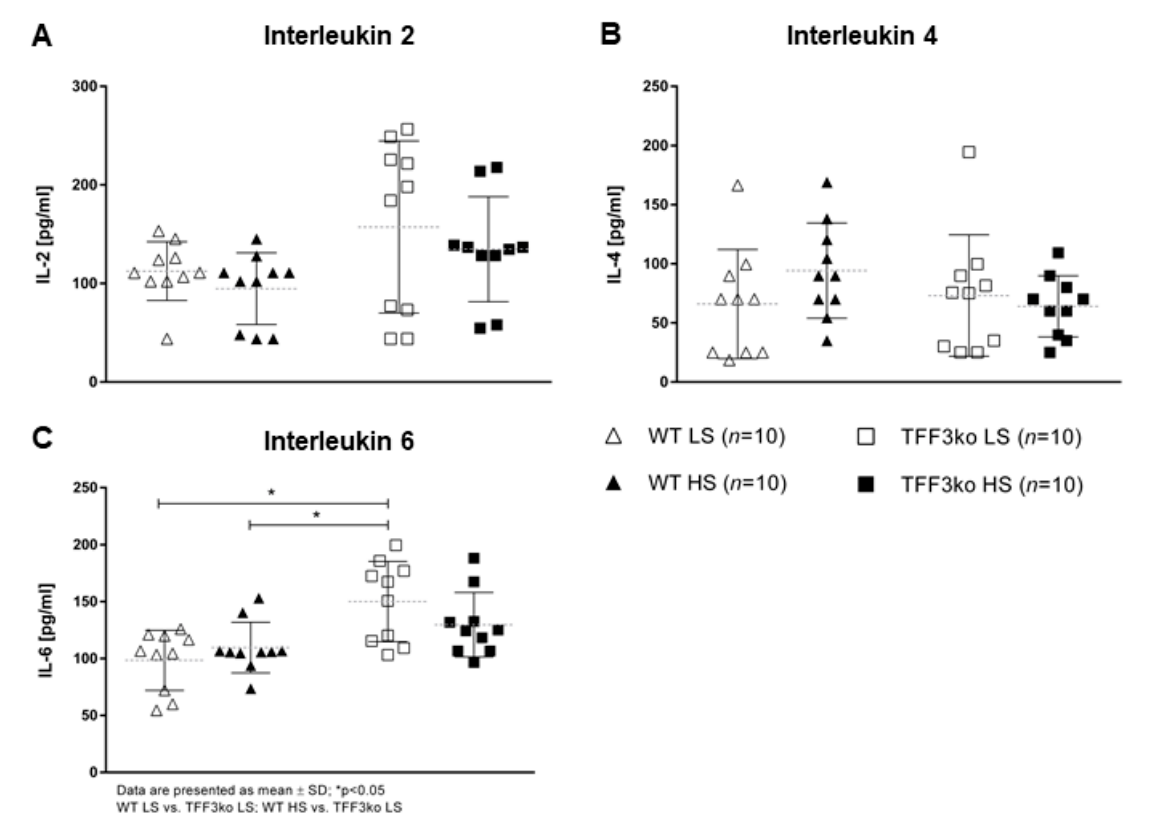
Figure 3. The serum concentrations of inflammatory markers IL-2 ( A ), IL-4 ( B ), and IL-6 ( C ) in Tff3 -deficient mice and their respective wild-type controls exposed to a 7-day high-salt diet. IL—interleukin; WT LS—wild-type (C57BL/6N) mice on a low-salt diet; WT LS—wild-type (C57BL/6N) mice on a high-salt diet; TFF3ko LS— Tff3 knock-out mice on a low-salt diet; TFF3ko HS— Tff3 knock-out mice on a high-salt diet. Data are presented as mean ± SD and were analyzed by one-way ANOVA or Kruskal–Wallis test where appropriate. * p -values less or equal 0.05 are considered significant.